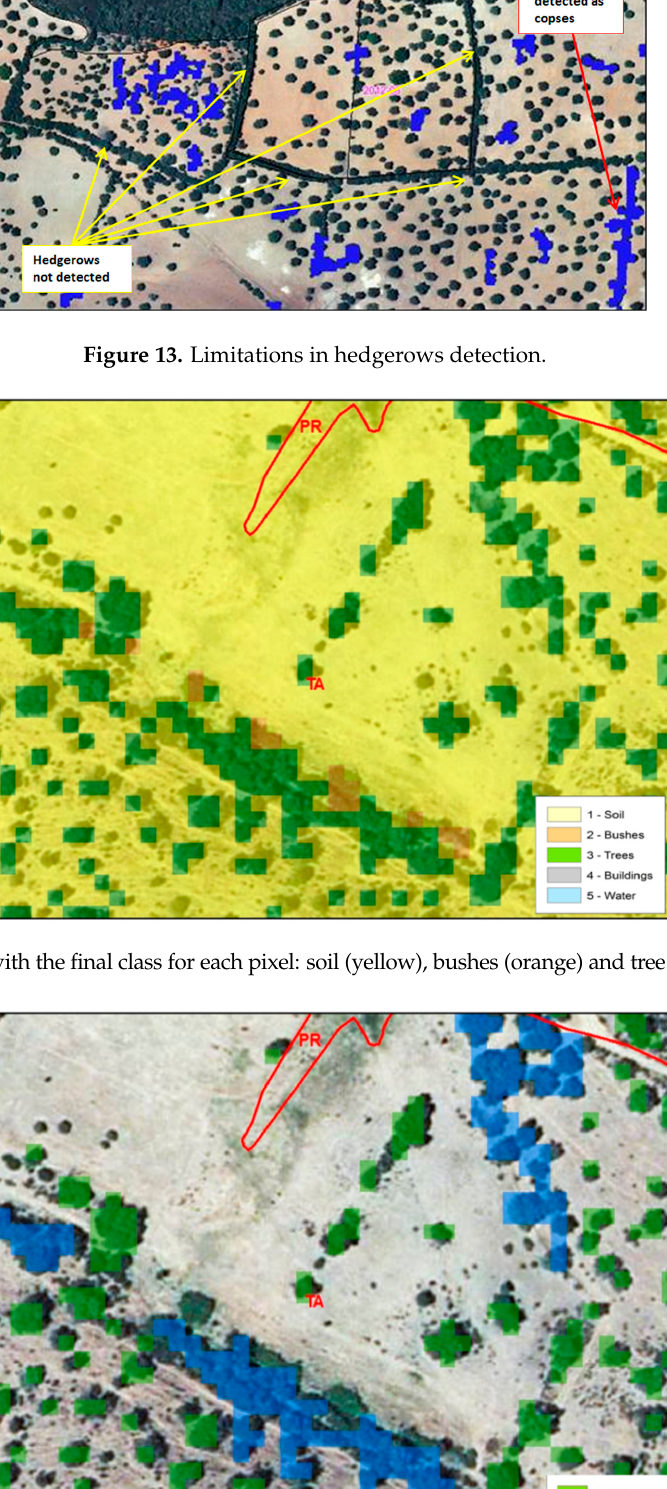
Figure 13. Limitations in hedgerows detection.